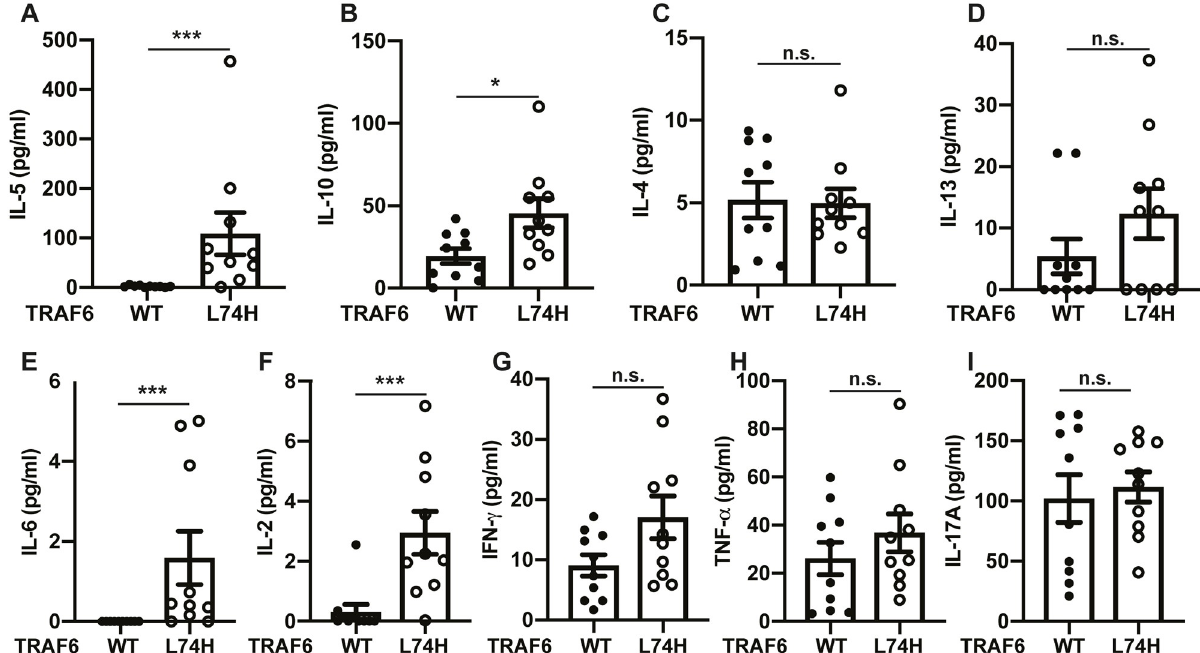
Fig 8. Serum cytokine levels in TRAF6[L74H] mice. (A-I) Bar graphs showing serum concentrations of IL-5 (A), IL-10 (B), IL-4 (C), IL-13 (D), IL-6 (E), IL-2 (F), IFN- γ (G), TNF- α (H), and IL-17A (I). The error bars show ± SEM. Symbols represent individual biological replicates. Statistical significance between the two genotypes was calculated using the unpaired t-test with Welch’s correction (IL-10, IFN- γ and TNF- α ) or the Mann- Whitney test (IL-4, IL-5, IL-13, IL-6, IL-2 and IL-17A). � denotes p < 0.05, �� denotes p < 0.01, ��� denotes p < 0.001 and n.s. denotes not significant difference. Individual values, descriptive statistics and results from the statistical analysis are provided in S8